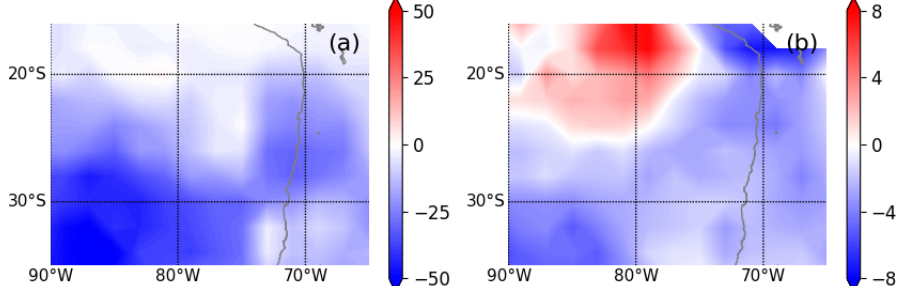
Figure 11. CESM2 mid-Pliocene minus CESM2 historical for (a) number of trough points (in number per decade) and (b) mean trough point strength (in gpm).